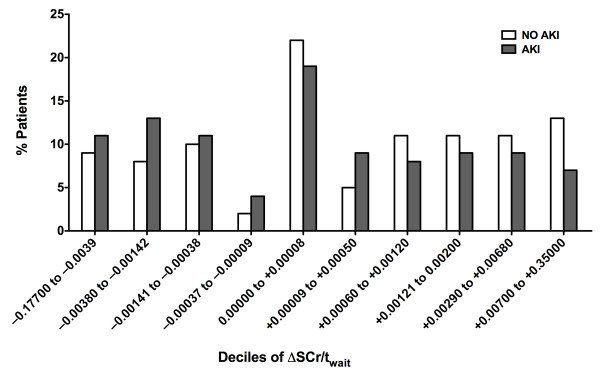
Distribution of rates of change of serum creatinine (ΔSCr/Δtwait) while awaiting orthotopic liver transplantation (OLT) in patients who did or did not develop post-OLT acute kidney injury (AKI). Patients were stratified in order to according to ΔSCr/Δtwait and subdivided into deciles containing equal numbers of patients. ΔSCr/Δtwait was defined as the absolute change of serum creatine (ΔSCr) while awaiting OLT (SCr pre-OLT minus SCr at registration) divided by the time awaiting OLT. The percentage of the total number of patients (n = 243) who developed AKI (AKI) falling within each decile is plotted. Similarly, the percentage of the total number of patients (n = 445) who did not develop AKI (NO AKI) within each decile is plotted. Negative values of ΔSCr/Δtwait correspond to improved renal function, while positive values of ΔSCr/Δtwait correspond to worsened renal function. The inverse relationship between degree of renal functional improvement and risk for AKI was statistically significant (p = 0.008).